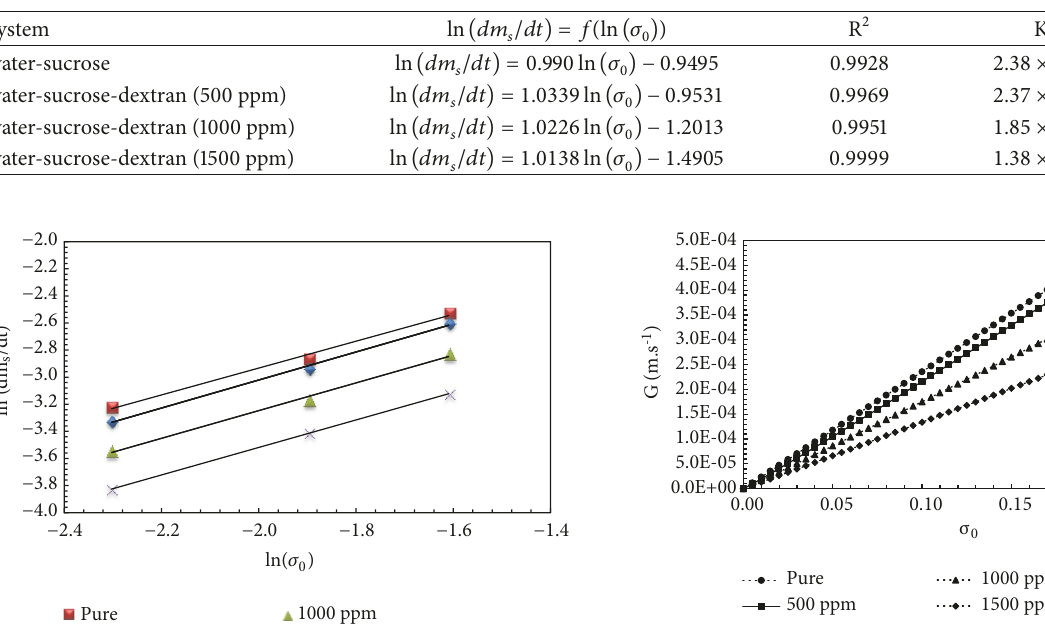
Table 4: Estimation of growth kinetic parameters.